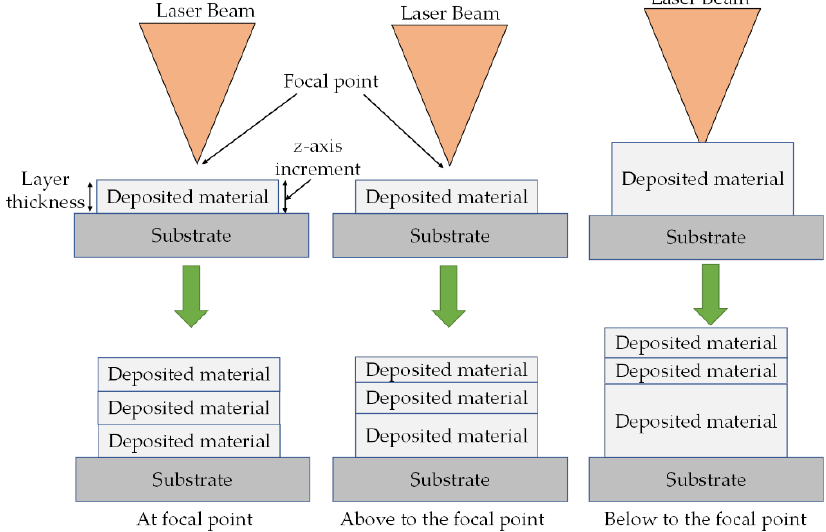
Figure 4. Correlation between growth along with the z -axis and layer thickness in LMD process; based on the data provided in Ref. [2,52].